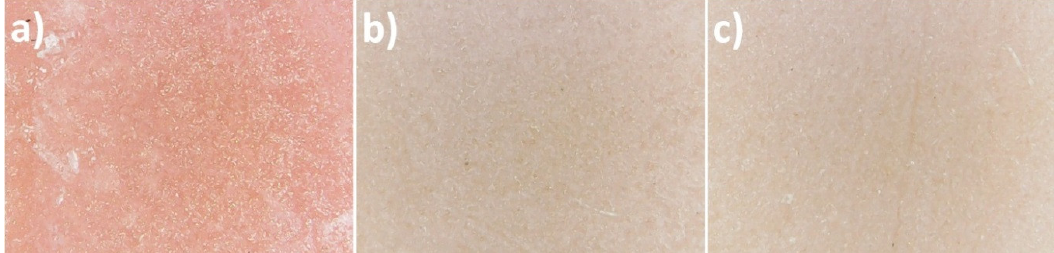
Figure 11. Photographs with the 60× magnification of the control group ( a ) and the test groups: 1% nanocomposite ( b ), 2% nanocomposite ( c ) . Table 7. Nanocomposite colour analysis.